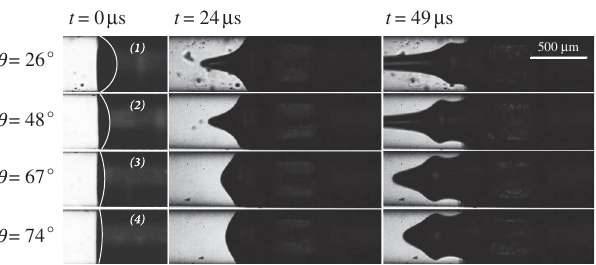
FIG. 5. Images showing the effect of varying the initial contact angle (cid:2) on the jet shape: (1) (cid:2) ¼ 26 (cid:2) , (2) (cid:2) ¼ 48 (cid:2) , (3) (cid:2) ¼ 67 (cid:2) , and (4) (cid:2) ¼ 74 (cid:2) . The first image (left column) shows the liquid in the capillary prior to the laser pulse, illustrating the initial contact angle and meniscus shape. The second image in each set (center column) is taken 24 (cid:1) s after the laser pulse, and the third image (right column) follows 25 (cid:1) s later. ((See Ref. [33] for the four related